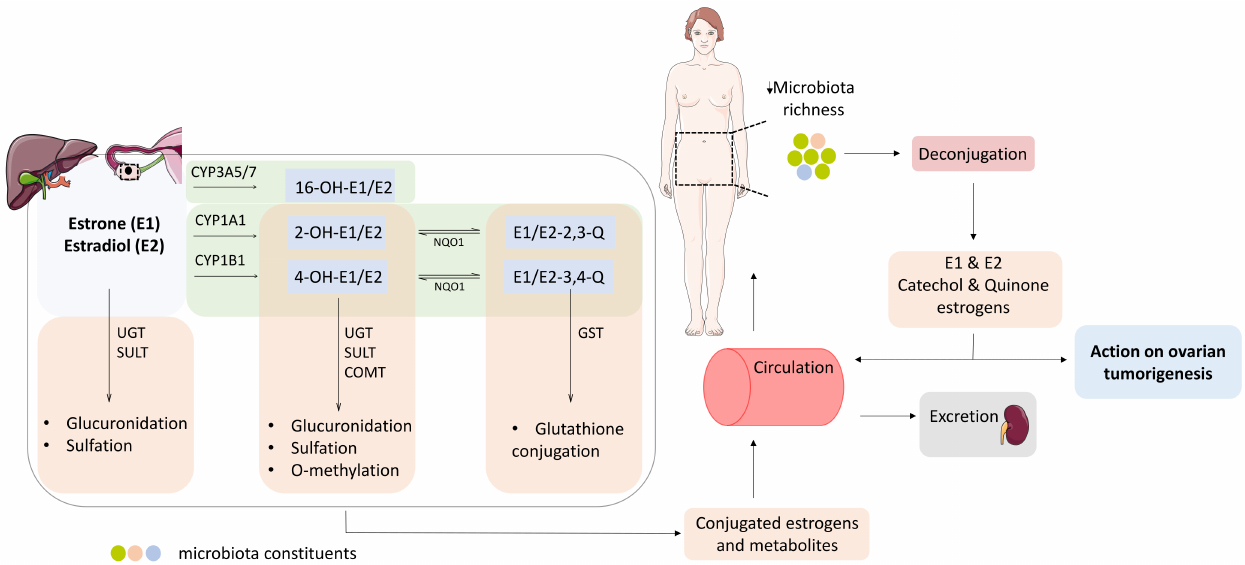
Figure 2. Estrogen metabolism in the liver and in the ovarian tumor tissue. Oxidation (light green boxes) is catalyzed by cytochrome P450 enzymes, and gives rise to catechol-estrogens: 2- and 4- OH estrone/estradiol, and 16-OH-estrone/estradiol (2-OH-E1/E2 and 4-OH-E1/E2, 16-OH-E1/E2). 2- and 4- catechol-estrogens are further oxidized to DNA-damaging quinones (E1/E2-2,3-Q and E1/E2-3,4-Q). Conjugation (light orange boxes) involves glucuronidation, catalyzed by UDP glucuronosyl transferases (UGT2B7), sulfation, catalyzed by sulfotransferases (SULT1A1, SULT1E1, SULT2B1), methylation, catalyzed by catechol-O-methyl transferase (COMT), and glutathione conjugation, catalyzed by glutathione S-transferases (GSTP1). The conjugated estrogens and their metabolites enter the systemic circulation and are eventually excreted from the body through urine and feces. The microbiome, more precisely the estrobolome, actively modulates the estrogen levels in the body. The microbiome change observed in OC patients, might contribute to the pool of estrogens available to the estrogen-responsive ovarian tumor by de-conjugating already conjugated estrogens and estrogen metabolites, hence to ovarian tumorigenesis. COMT, catechol-ortho-methyl transferase; CYP1A1, cytochrome P450 1A1; CYP1B1, cytochrome P450 1B1; CYP3A5, cytochrome P450 3A5; CYP3A7, cytochrome P450 3A7; GST, glutathione-s-transferase; NQO1, NAD(P)H quinone oxidoreductase 1; SULT, sulfotransferase; UGT, uridine 5’ diphospho-glucuronosyl transferase. Parts of the figure were drawn by using pictures from Servier Medical Art. Servier Medical Art by Servier is licensed under a Creative Commons Attribution 3.0 Unported License (https://creativecommons.org/licenses/by/3.0/) (accessed on 7 May